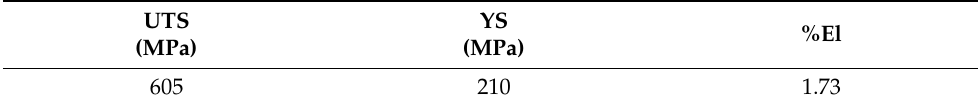
Table 5. Tensile properties of alloy A in the as-cast condition.